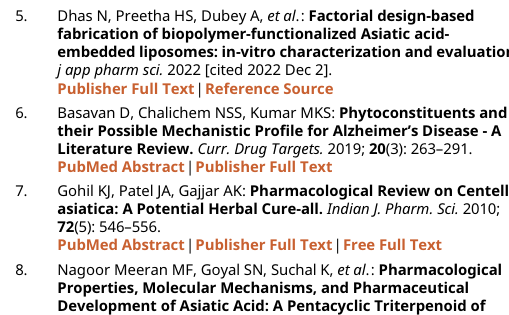
Data are available under the terms of the Creative Commons Attribution 4.0 CC-BY (Attribution)